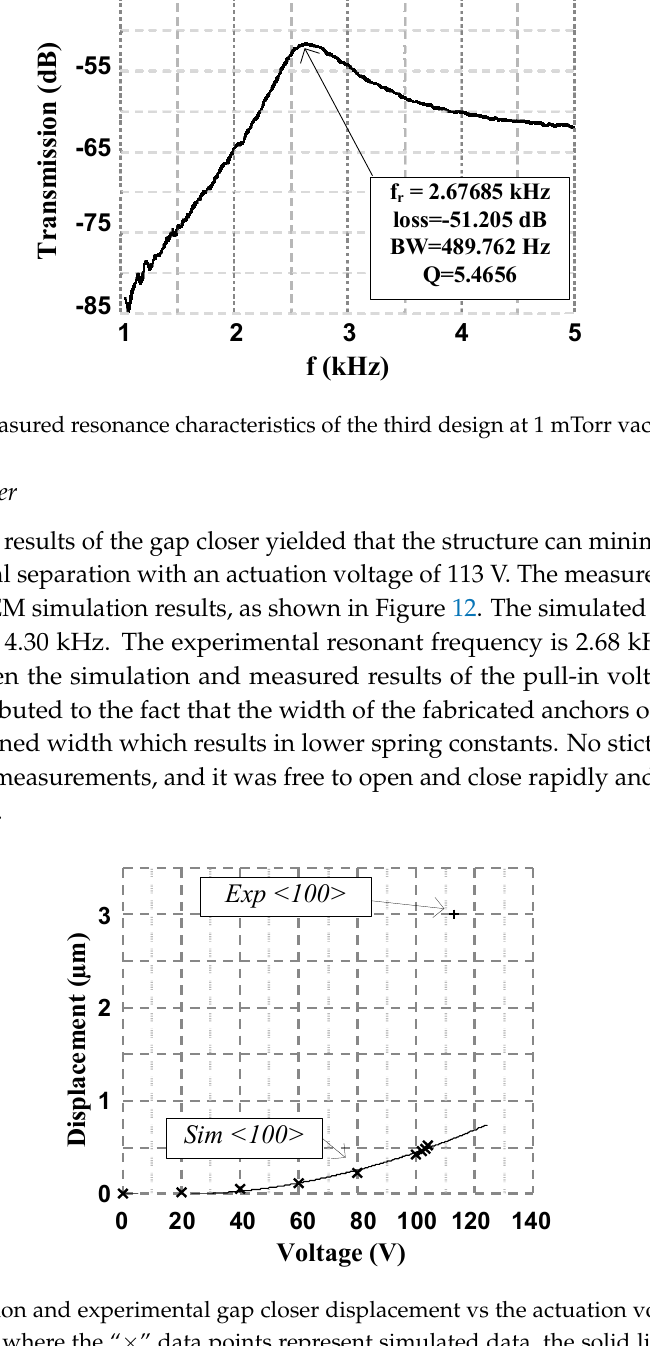
anchor orientation where the “ × ” data points represent simulated data, the solid line is a fit to the